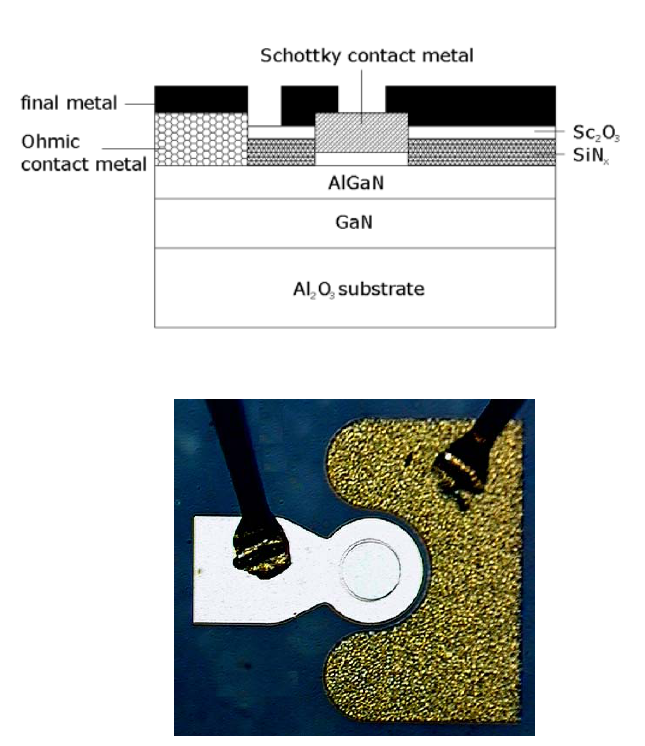
Figure 2. Cross-sectional schematic of completed MOS diode on AlGaN/GaN HEMT layer structure (top) and plan-view photograph of device